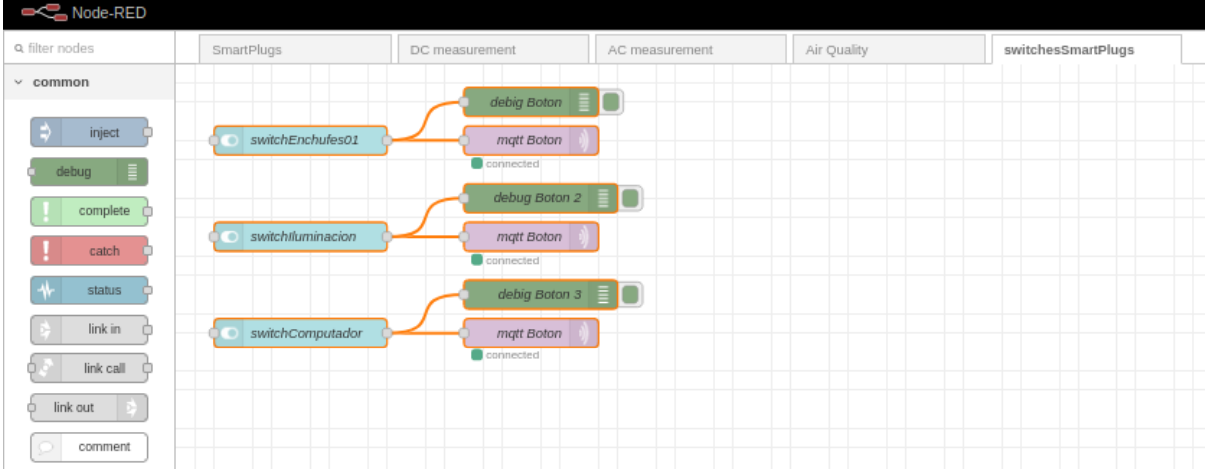
Figure 8. Configuration for Node-RED for the control of smart plugs.